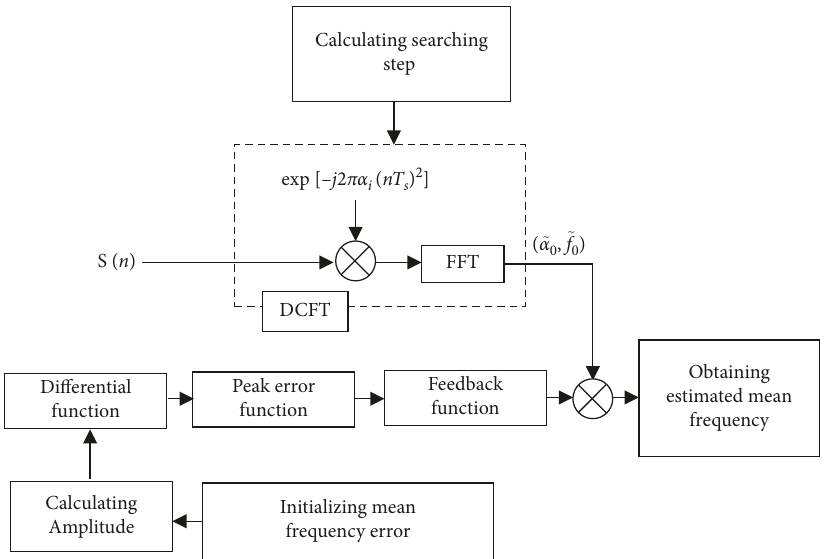
Figure 1: The two-step method’s flow diagram combining DCFTfor coarse frequency estimation and MLEP for fine frequency